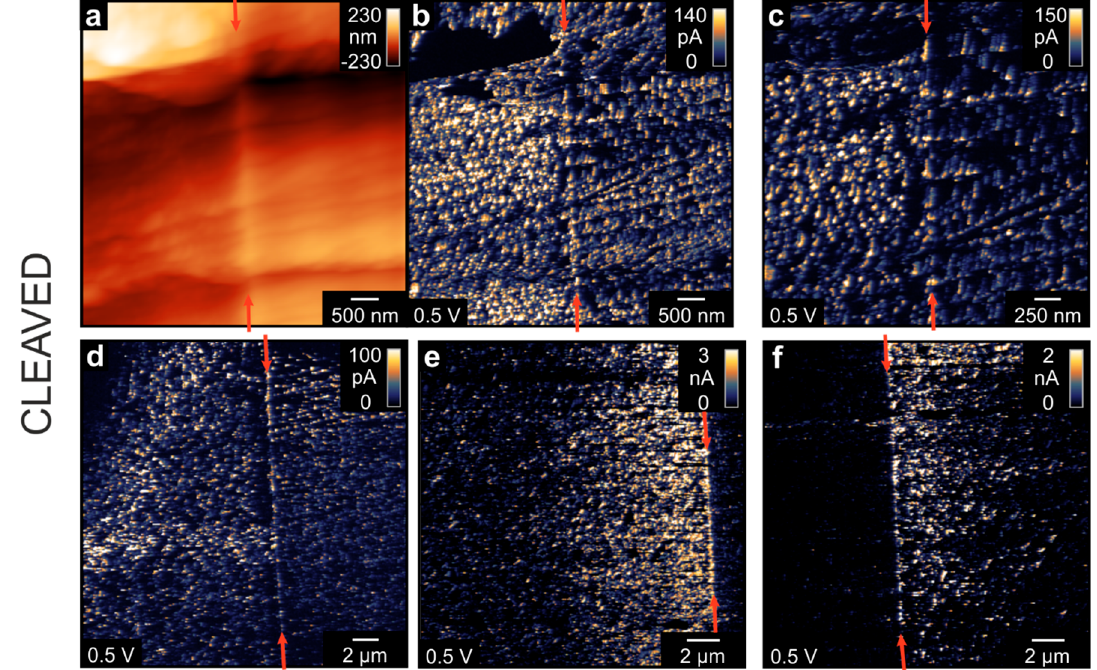
Figure 4. LC-AFM analysis of the 36.8° bicrystal junction after cleaving measured at room temperature. ( a ) Topography with ( b ) corresponding current map and ( c ) magnification; ( d – f ) current maps obtained at different positions along the junction on the cleaved surface.